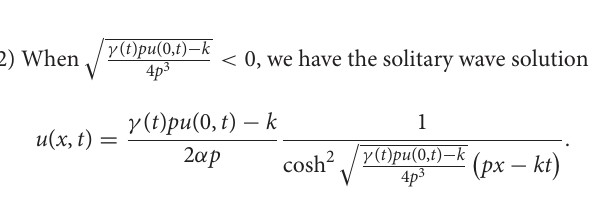
FIGURE 2 | Solitary wave solution of the loaded KdV equation for k